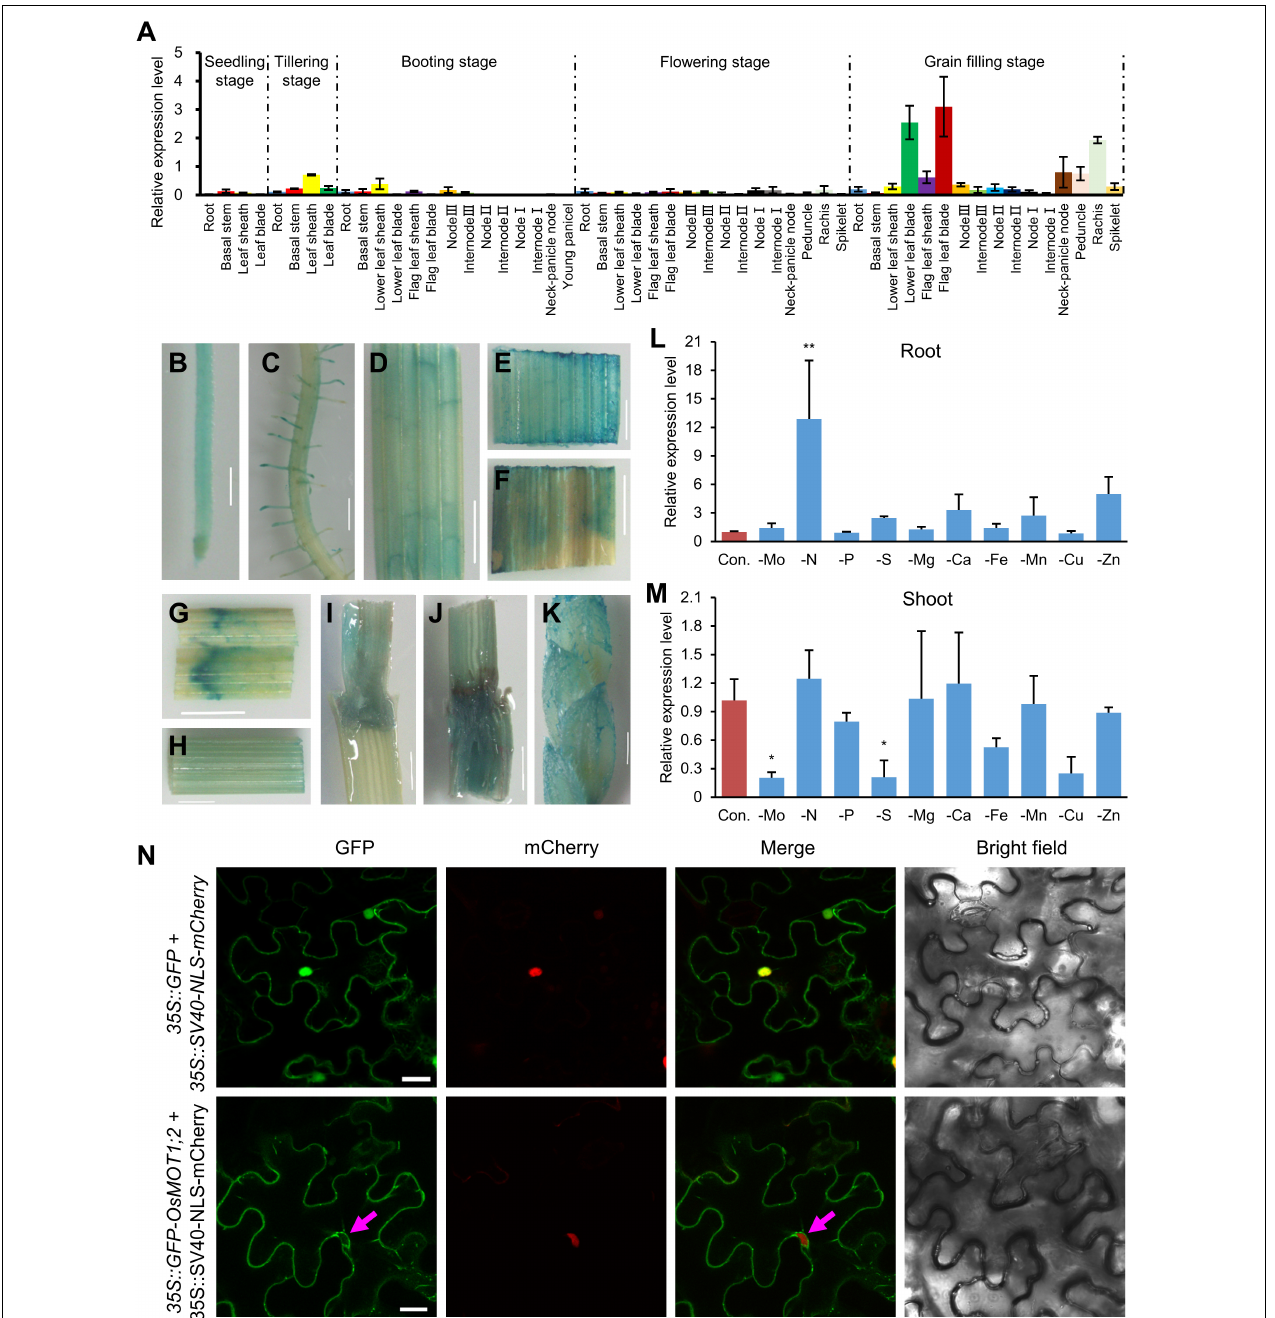
FIGURE 2 | Expression pattern and subcellular localization of OsMOT1;2. (A) Relative expression level of OsMOT1;2 in different tissues of ZH11 at different growth stages. Samples were collected from the plants grown in a paddy field, and the relative expression level was determined by qRT-PCR. The expression level of OsMOT1;2 was normalized to the housekeeping gene OsActin and shown as 2 − (cid:49) Ct . (B–K) Histochemical GUS ( β -glucuronidase) staining of different tissues of transgenic plants transformed with the GUS construct driven by the OsMOT1;2 promoter. GUS staining was performed in the root (B,C) , blade (D) , and sheath (E) of 14-day-old transgenic plants grown hydroponically, and the flag leaf blade (F) , flag leaf sheath (G) , internode 2 (H) , node 2 (I) , node 3 (J) , and the spikelet (K) of transgenic plants grown in potting soils at the grain filling stage. Bar, 0.5 cm. (L,M) Expressions of OsMOT1;2 under different nutrient deficiencies. Two-week-old plants were treated for 1 week in the nutrient solution with different nutrient depletions. Expressions of OsMOT1;2 were determined in roots (L) and shoots (M) by qRT-PCR. (N) Subcellular localization of OsMOT1;2. OsMOT1;2 was fused with green fluorescence protein (GFP) at N-terminus and expressed in tobacco leaves by a cauliflower mosaic virus 35S promoter. The 35S:SV40-NLS-mCherry was co-expressed to show the location of the nucleus. The magenta arrows show the GFP fluorescence in the inner side of the nucleus. Bar, 20 µ m. Data in (A,L,M) are presented as means ± SD with three biological replicates. Columns with * or ** in (L,M) indicate significant differences between the treatment and the control at P < 0.01 or P < 0.05 (Dunnett’s multiple comparison test).